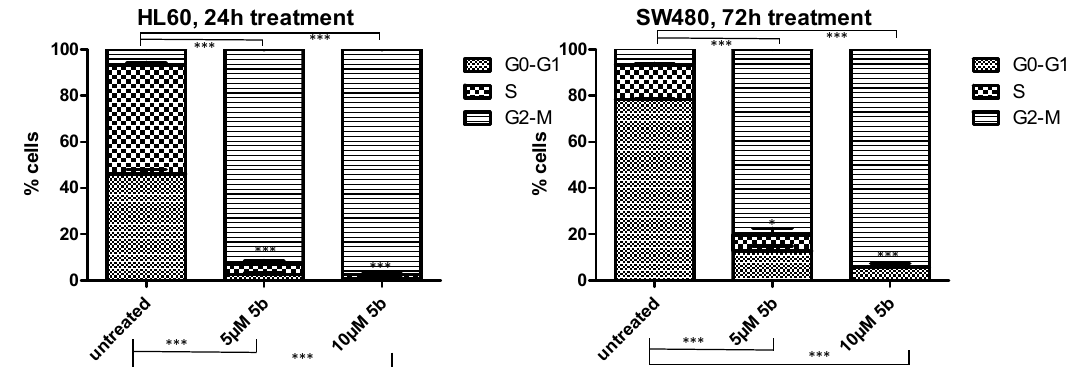
Figure 6. Cell cycle analysis of HL60 and SW480 cells treated with compound 5b . A massive G2/M arrest was detected, showing at 10 µM almost no cell dividing. Significance was designated as * for P < 0.05 and *** for P < 0.001. Error bars depict ± SD.